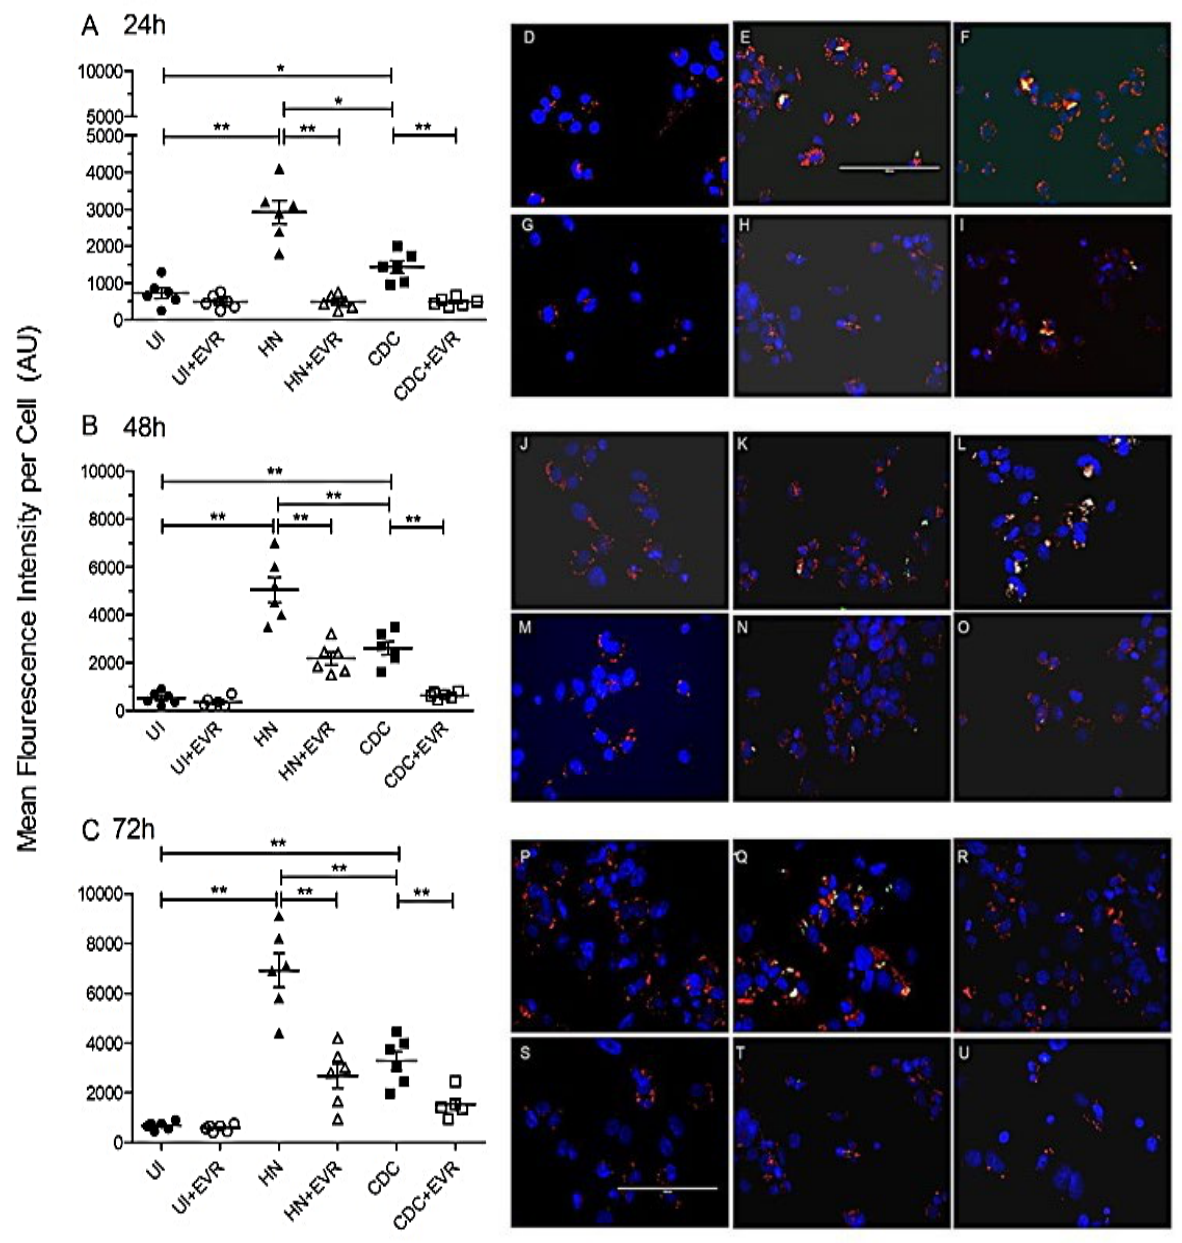
Figure 3: Quantification of Mean Fluorescent Intensity for Oil Red Staining : M. tb (CDC1551 or HN878)-infected macrophages cultured in the presence and absence of everolimus (0.5 mg/ml) were terminated at 24h (Figure 3A), 48h (Figure 3B), and 72h (Figure 3C) post-infection. Lipid bodies were stained with Oil red (Sigma-Aldrich, 0.1 µg/ml, from a stock solution in methanol) for 15 min. The samples were then washed with PBS, fixed for 30 min in PBS-PFA 4%, and mounted with the fluorescent DAPI-mounting medium. The slides were observed under a confocal microscope. Mean Fluorescent Intensity was calculated using ImageJ software.Figure 3D, E, F, G, H, I, J, K, L, M, N, O, P, Q, R, S, T and U areimages showing Oil Red Staining . M. tb (CDC or HN878)-infected macrophages cultured in the absence (Figure 3D, E, F, J, K, L, P, Q, R) and presence (Figure 3G, H, I, M, N, O, S,T,U ) of everolimus (0.5 mg/ml) were terminated at 24h (D,E,F,G,H,I), 48h (J,K,L,M,N,O) and 72 h (P, Q,R,S,T,U) post-infection. Lipid bodies were stained with Oil red for 15 min. The samples were then washed with PBS, fixed for 30 min in PBS-PFA 4%, and mounted with the fluorescent DAPI-mounting medium. The slides were observed under a confocal microscope. Images were captured under